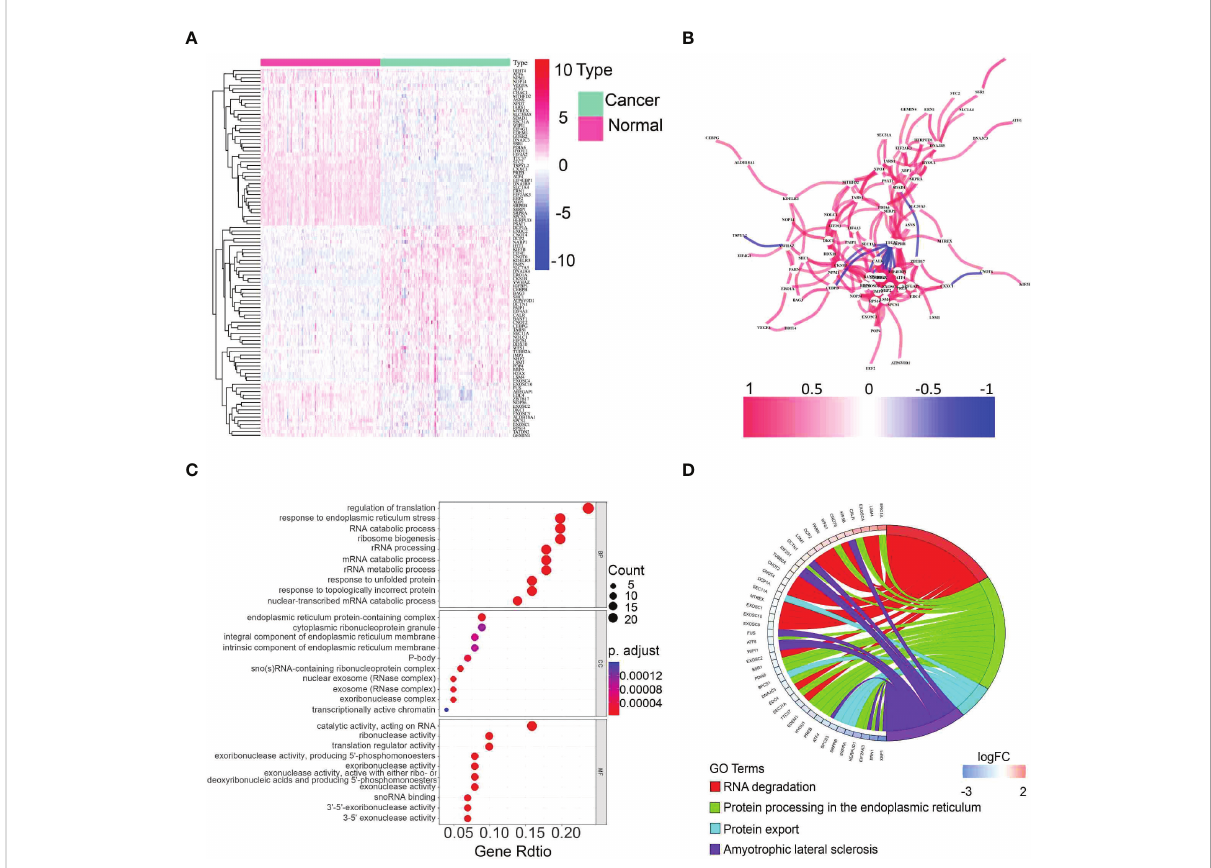
FIGURE 2 Identi fi cation of differentially expressed UPR-related genes and functional annotation. (A) A heatmap showing the expression of differentially expressed UPR-related genes in normal and cancer tissues in the TCGA. (B) The correlation network of selected candidate genes. (C) GO enrichment analysis. (D) KEGG pathway enrichment